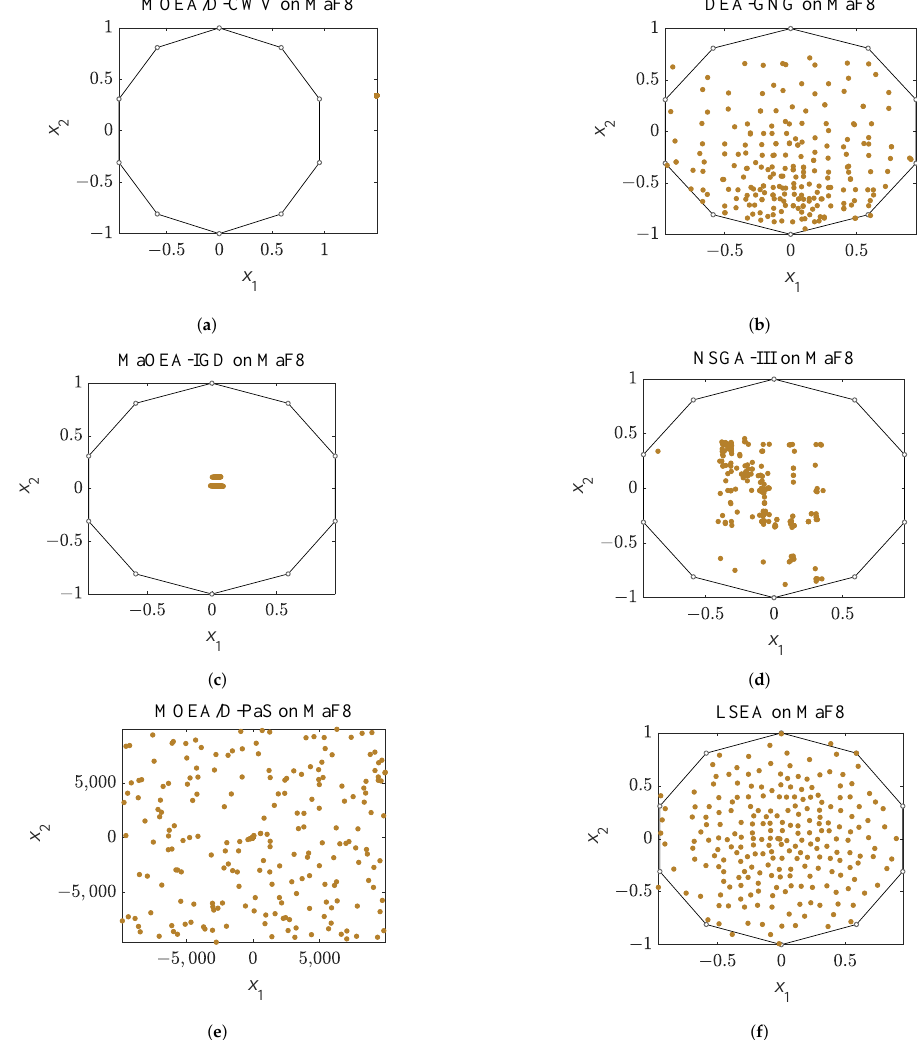
Figure 4. Distributions of populations in decision space of the six algorithms on 10-objective MaF8. ( a ) output population of MaOEA-IGD, ( b ) output population of DEA-GNG, ( c ) output population of MaOEA-IGD, ( d ) output population of NSGA-III, ( e ) output population of MOEA/D-PaS, ( f ) output population of